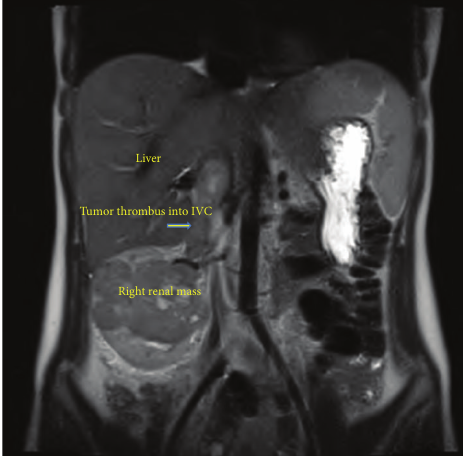
Figure 2: Coronal images of magnetic resonance imaging scan showing tumor thrombus extending into inferior vena cava.